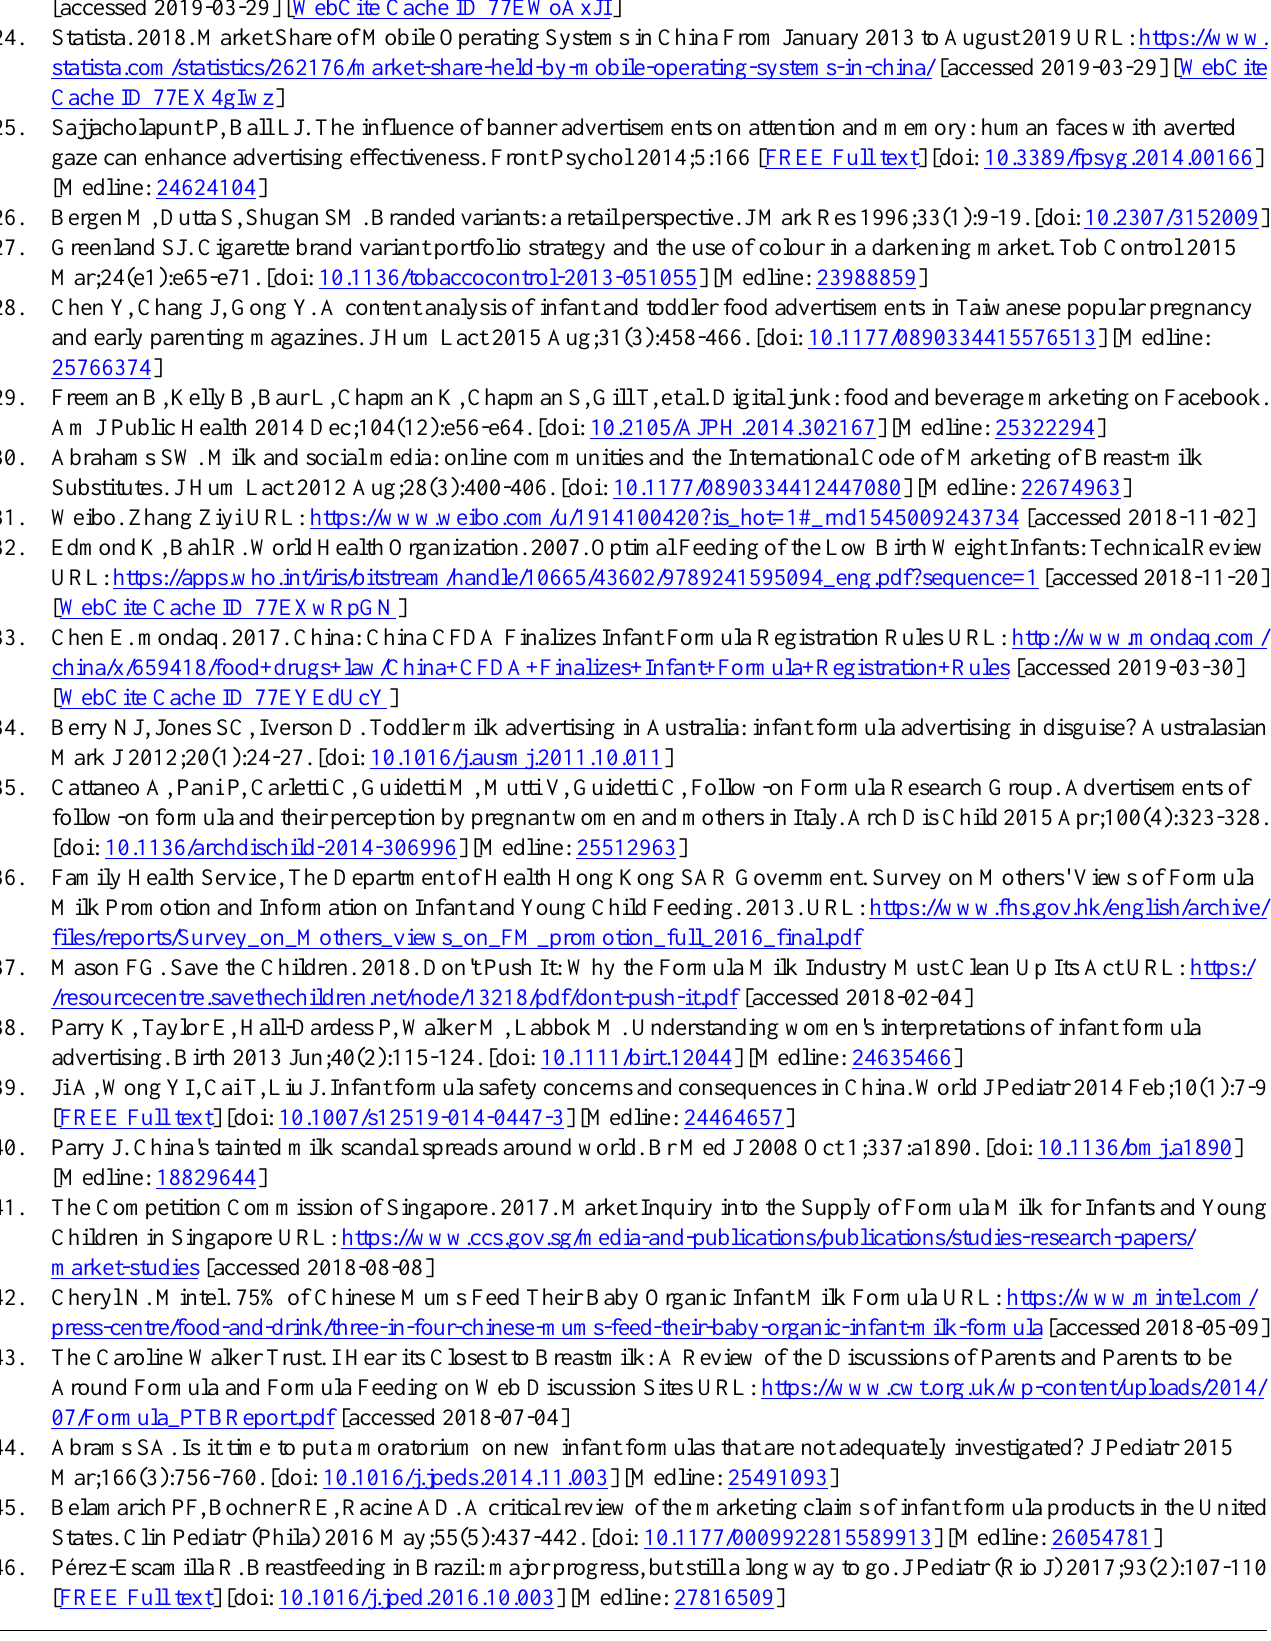
BMS: breast milk